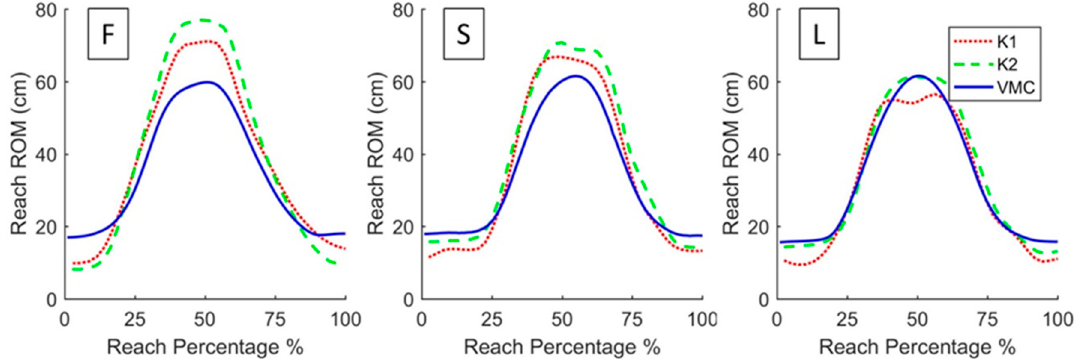
Figure 3. Three sets of curves showing reach ROM from start to stop of a typical reaching movement. The left curve (F) represents a forward reach, the middle curve (S) represents a scaption reach, and the right curve (L) represents a lateral reach. Curves for the K1, K2, and VMC are shown separately (see